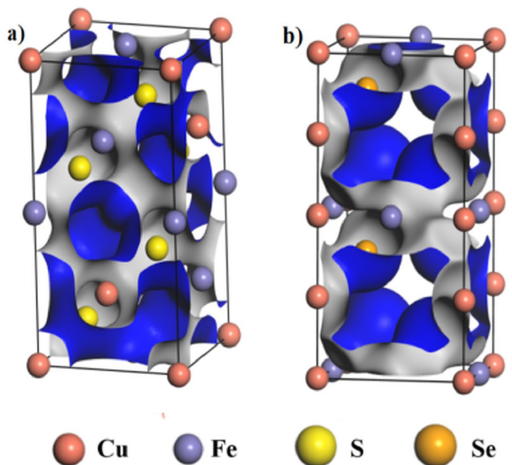
and (b) CuFeS 2 2